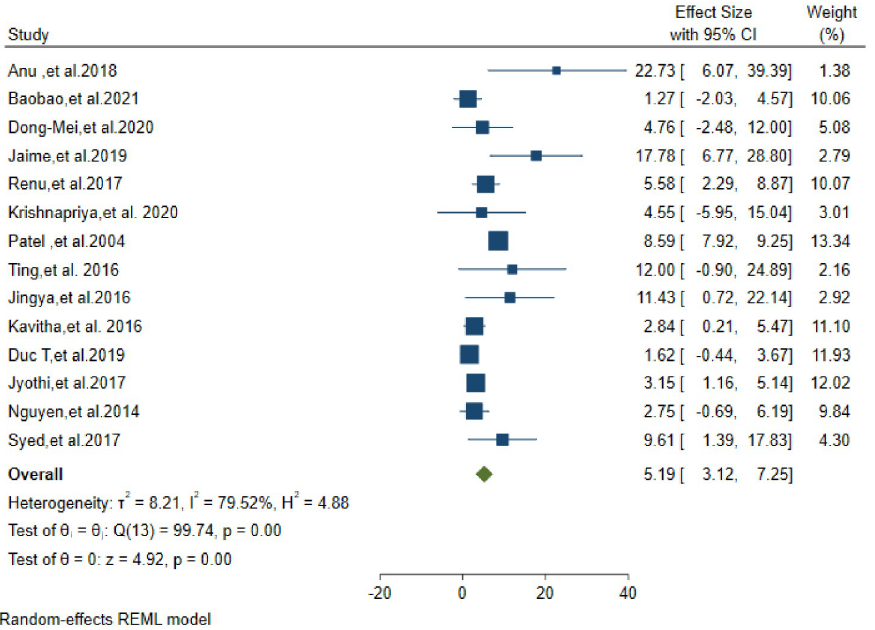
Fig 4. Pooled estimate of MDR-TB prevalence in Tuberculosis confirmed